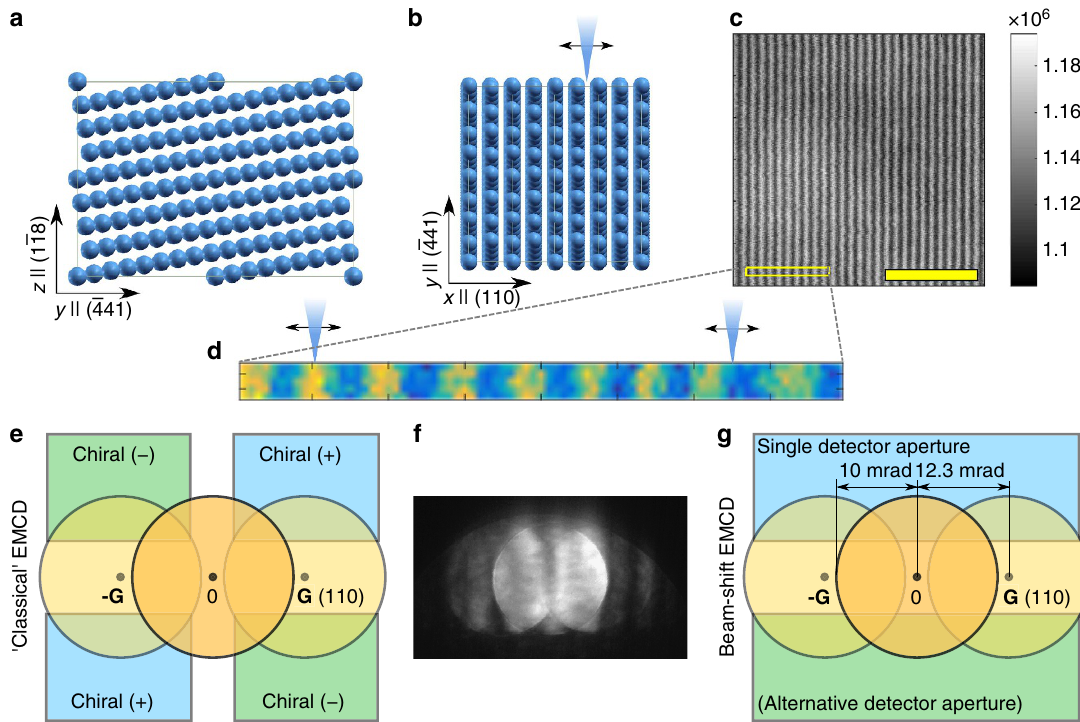
Figure 1 | Scheme of the experimental set-up. ( a ) Side-view of the structure model of bcc iron tilted into a 3-beam orientation with the beam along the 1 (cid:2) 18 ð Þ direction. ( b ) Top view of the structure model. Scanning direction is schematically shown by blue cone with arrows. ( c ) ADF survey image (acceleration voltage 200kV, convergence semi-angle 10mrad) showing atomic planes. The yellow scale bar denotes 2Å. ( d ) ADF image acquired along with the acquisition of a spectrum image. Its size corresponds to the yellow rectangle marked in the ADF survey image. ( e ) Schematic placement of detectors for a classical EMCD approach in the 3-beam orientation. ( f ) Experimental diffraction pattern acquired in the same settings as the ADF survey image. ( g ) Detector placement in the here-proposed APR-EMCD approach. Note that in the classical approach we need two measurements at each beam position to acquire both chiral ( þ ) and chiral ( (cid:2) ) spectra, while in the APR-EMCD a single detector aperture is